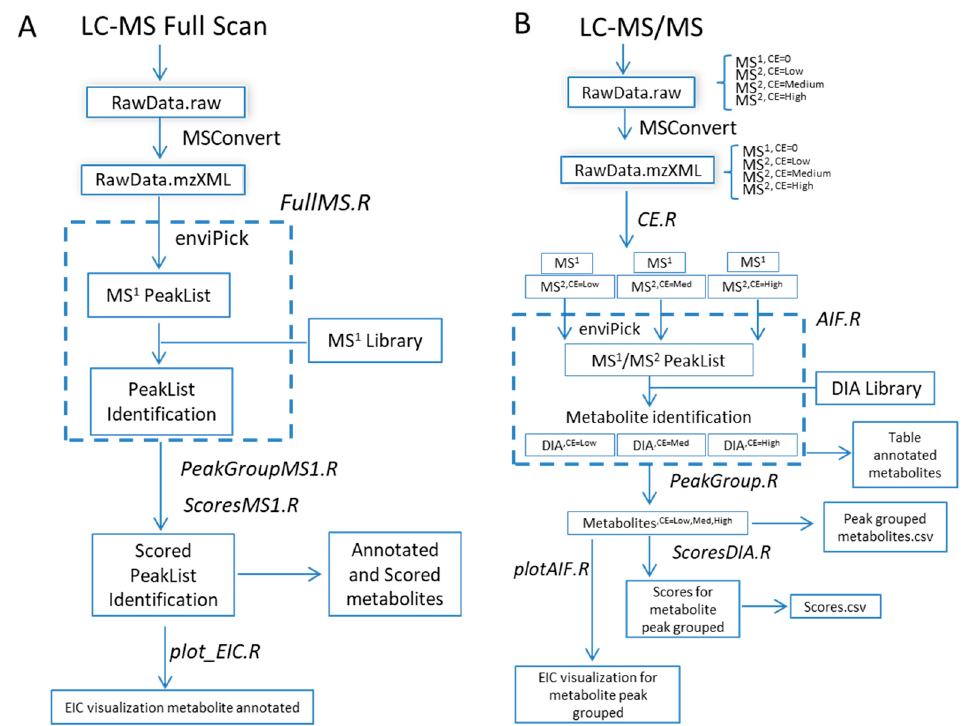
Figure 1. Overview of the R-MetaboList 2 workflow pipeline. ( A ) Initially, the raw data from an LC-MS full-scan experiment is converted to an .mzXML file format using MSConvert or other software. The file converted is processed by the FullMS.R function which performs a peak picking with the embedded enviPick algorithm to generate a peak list. A metabolite library consisting of neutral masses with optional retention time annotations is used by the FullMS.R function to provide a list of annotations that are grouped by metabolite assignment by the PeakGroupMS1.R function. Finally, the function ScoresMS1.R evaluates the isotope peak intensity ratio (IPIR), peak-to-peak Pearson correlation (PPC), and peak-to-peak shape (PPS) scores for each given metabolite. Finally, visualization of the extracted ion chromatogram (EIC) for the annotated metabolite is produced by the plot_EIC.R function. ( B ) Raw data from LC-MS / MS full-scan experiment is converted to an .mzXML file format which is further separated by collision energy ( CE.R ). MS 1 at CE 0 and one MS 2 per CE are processed by the AIF.R function, which performs a targeted extraction and putative annotation when an MS / MS library is provided. Peak grouping across CE values is performed with the PeakGroup.R function followed by scoring with the ScoresDIA.R function to evaluate the annotation